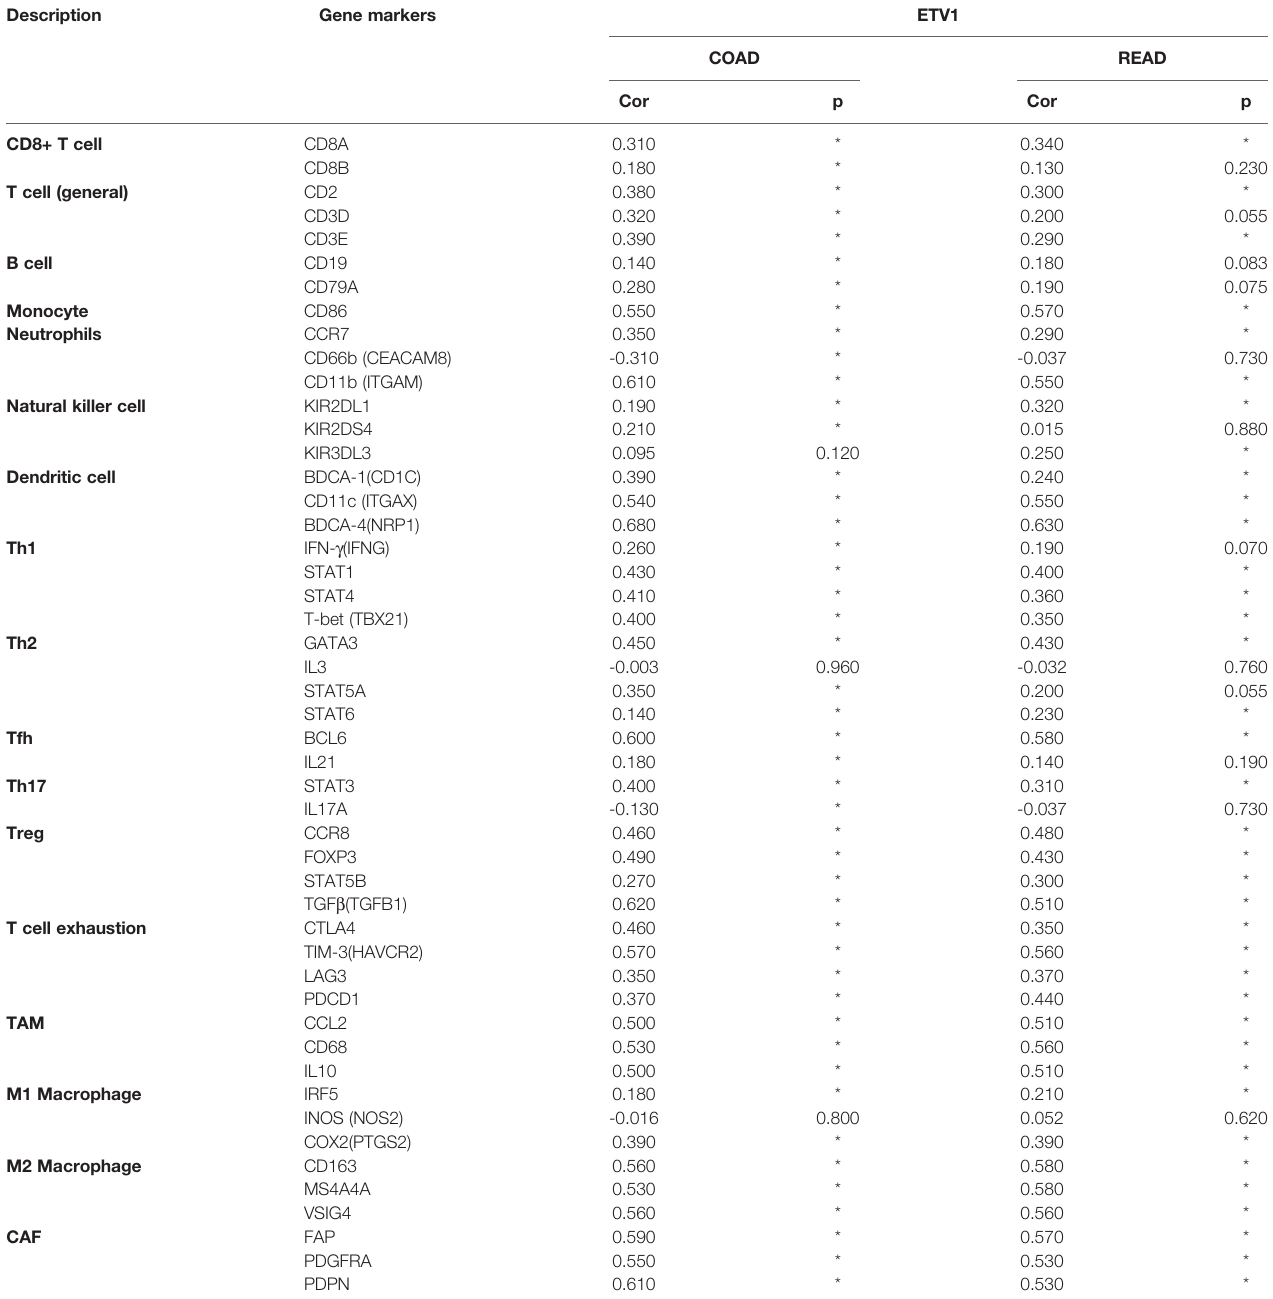
TABLE 4 | Correlation analysis among ETV1 and related gene markers of immune cells in GEPIA. Description Gene